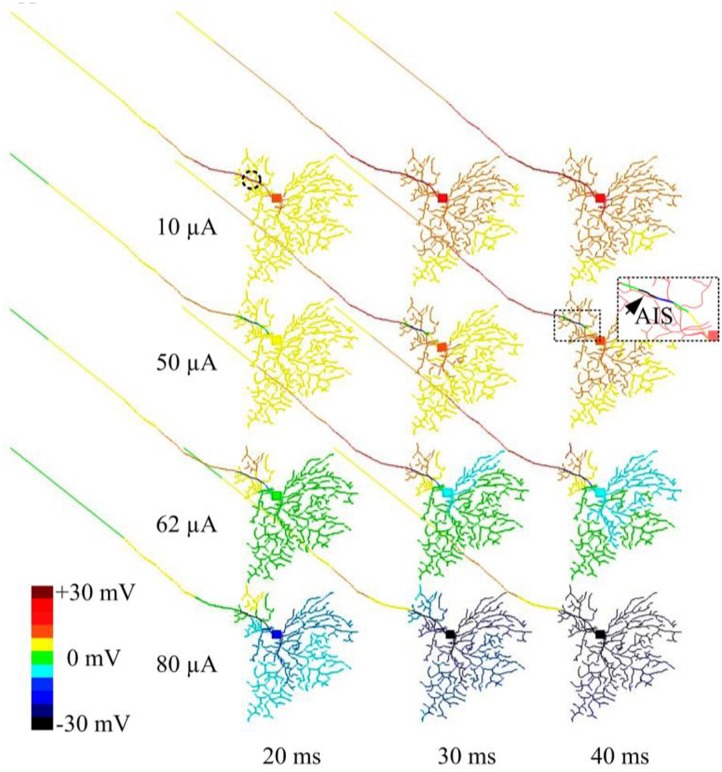
Modeled time-dependent membrane potential suppression with constant-amplitude 2-kHz HFS. The RGC model was stimulated by 10, 50, 62, and 80 μA 2 kHz HFS. At each stimulation level, baseline membrane potential at multiple time points (20, 30, and 40 ms after the stimulation onset) were obtained. At a stimulus amplitude of 10 μA, membrane potential across the whole cell was increasingly depolarized over time. At an amplitude of 50 μA, cumulative local membrane hyperpolarization (indicated by the arrow) was evident near the stimulation electrode (dashed circle). For stimulus pulses of 62 and 80 μA, most cellular regions were increasingly hyperpolarized.